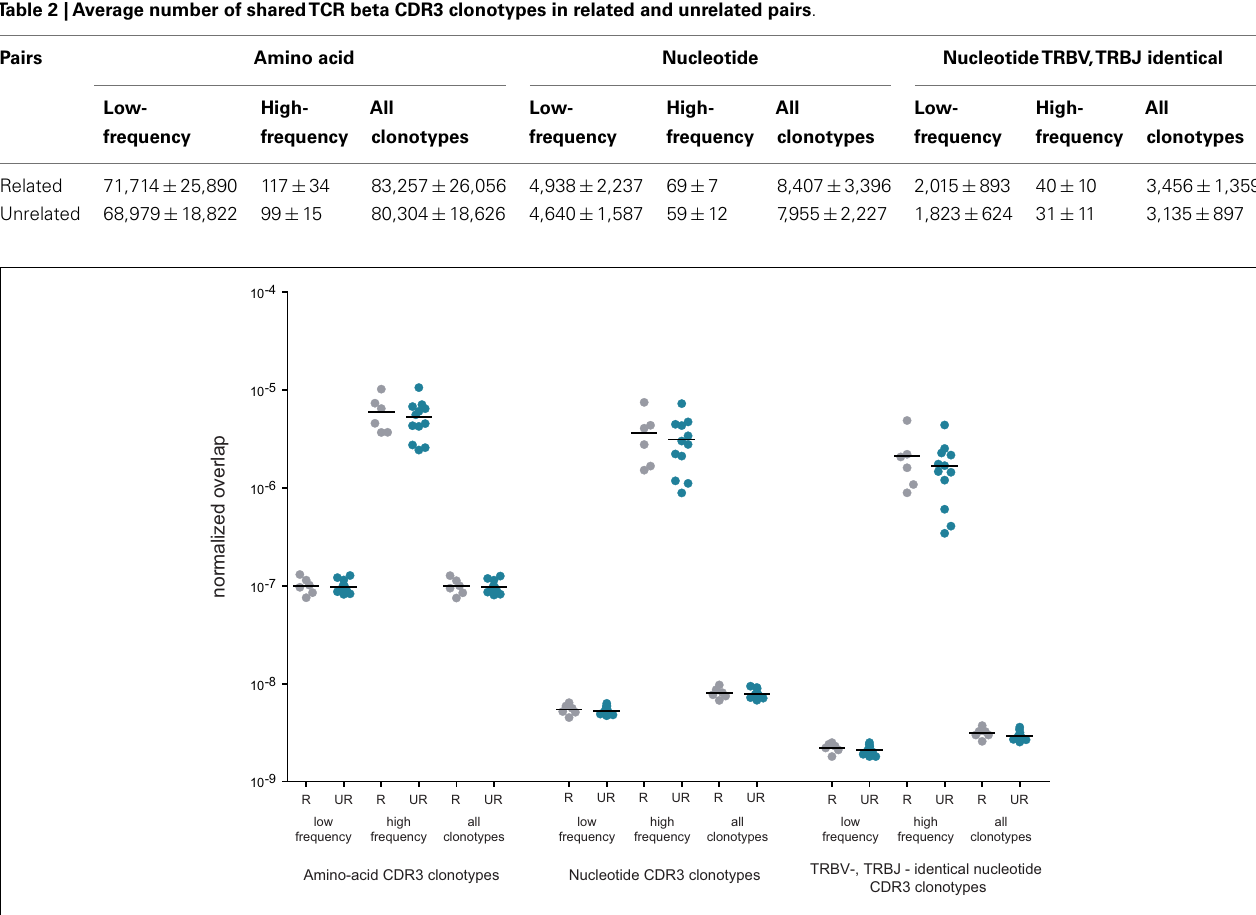
FIGURE 5 | Normalized overlap of individualTCR beta repertoires . Overlaps are shown at the level of CDR3 amino acid sequences, nucleotide sequences, and nucleotide sequences with identicalTRBV andTRBJ segments; for related (gray) versus unrelated (blue) mother-child pairs; and for low-frequency, high-frequency, and all in-frame clonotypes.The number of intersections was normalized as described in Formula 1. R, related pairs; UR, unrelated pairs.